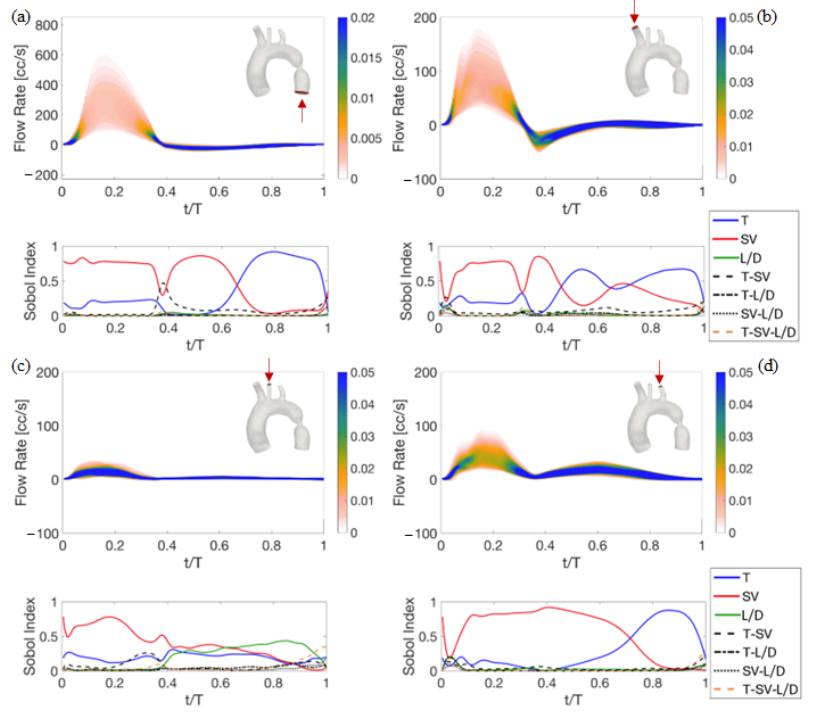
Figure 15. PDF of the waveforms of the flow rate (top panel) and relative Sobol indexes (bottom panel) at the four outlets of the coarctated aorta: ( a ) DA, ( b ) BCA, ( c ) LCCA, and ( d ) LSA. As for the PDFs and Sobol indexes for the differential pressure waveforms shown in Figure 16, the stroke volume is still the main parameter affecting result variability in the systole, with a significant effect of T as well and negligible ones for L / D and interactions. During the diastole, again characterized by a lower variability in terms of differential pressure, SV is the main parameter when dealing with healthy and aneurismatic geometries, whereas the period T is the most effective for the diastolic phase in the coarctated aorta.